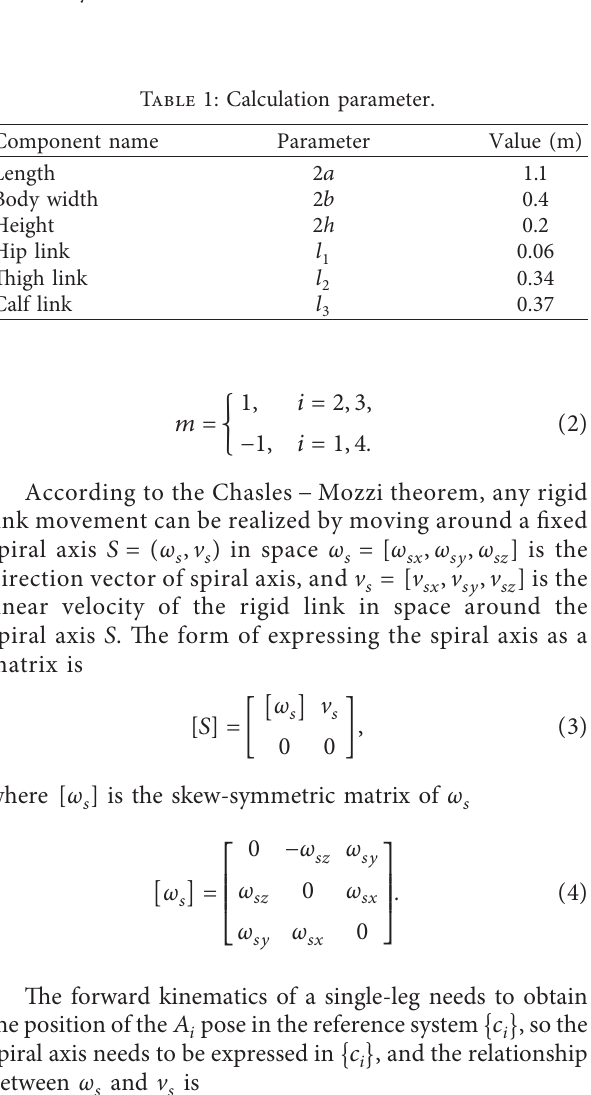
Figure 1: The quadruped robot PoE method establishes the co- ordinate